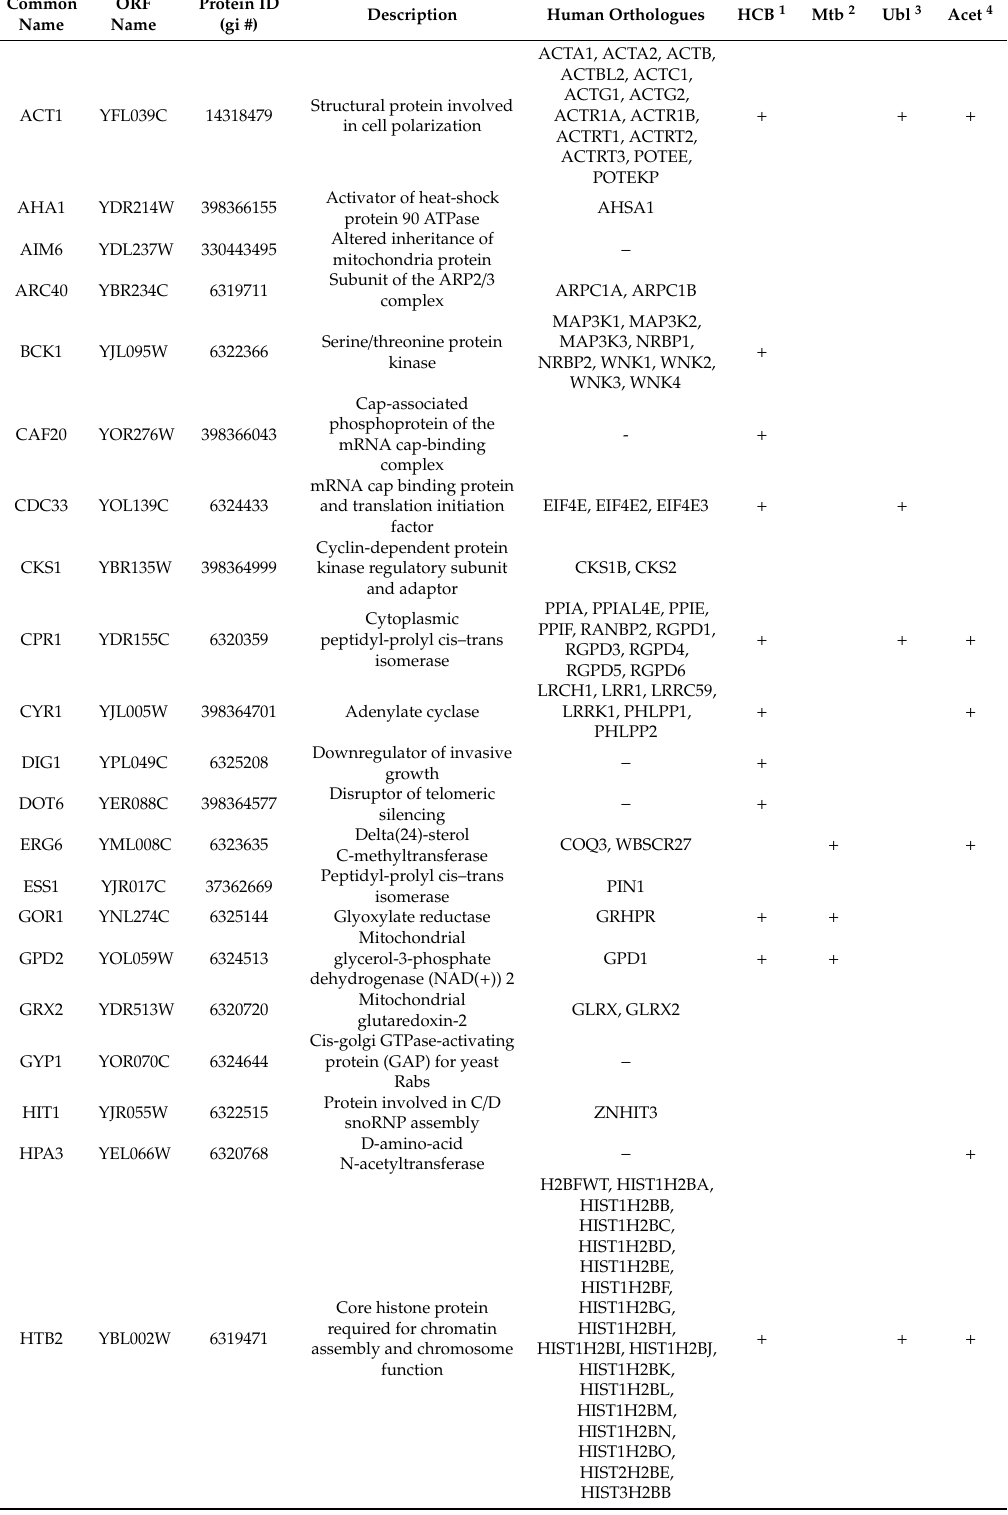
Table 1. List of bound proteins found only in extracts from hypoxic